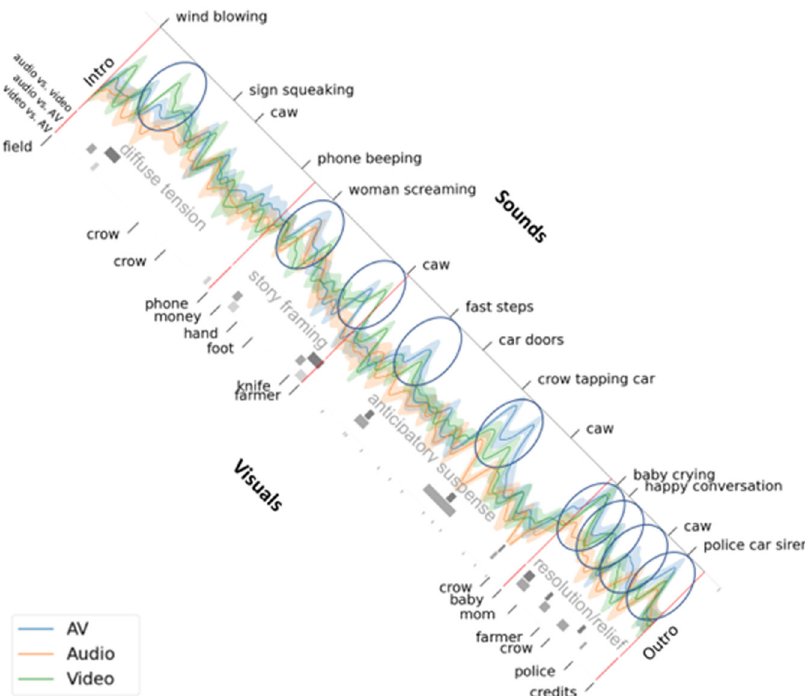
Fig. 3 Visualization of event structure, de fi ned by the coding protocol ( y -axis ticks for the events and gray labels for the plot phases) and the signi fi cant IBI differences between conditions (blue circles). The small letters on the minor primary x -axis indicate the appearance of the two recurrent themes: the crow (C) and the farmer (F).